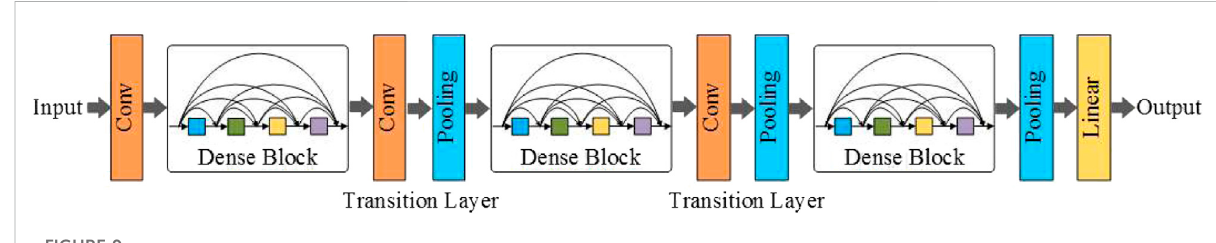
FIGURE 9 The feature map in the dense block has the same size, and the transition layer completes down-sampling.